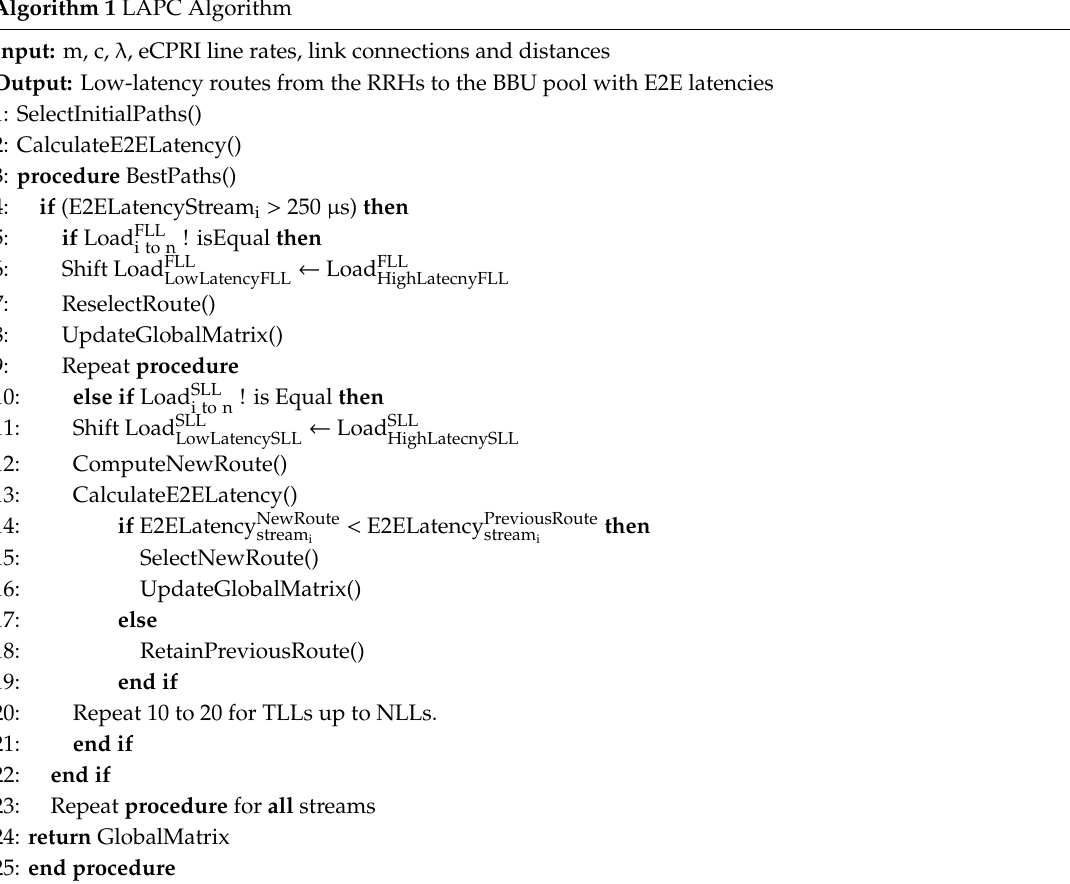
Algorithm 1 LAPC